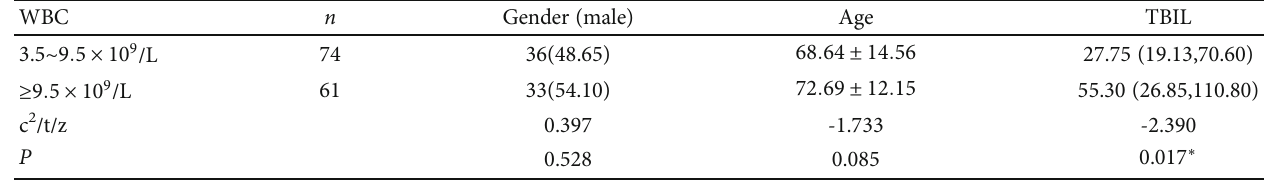
Table 1: Contrast table of gender, age, and total bilirubin value in two groups.